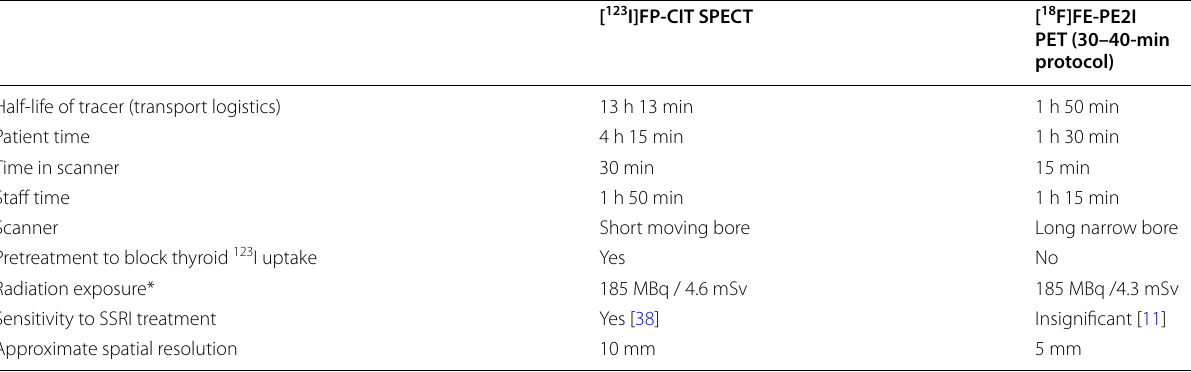
SSRI selective serotonin reuptake inhibitors Time estimates are based on logistics in our high throughput clinic with 20–30